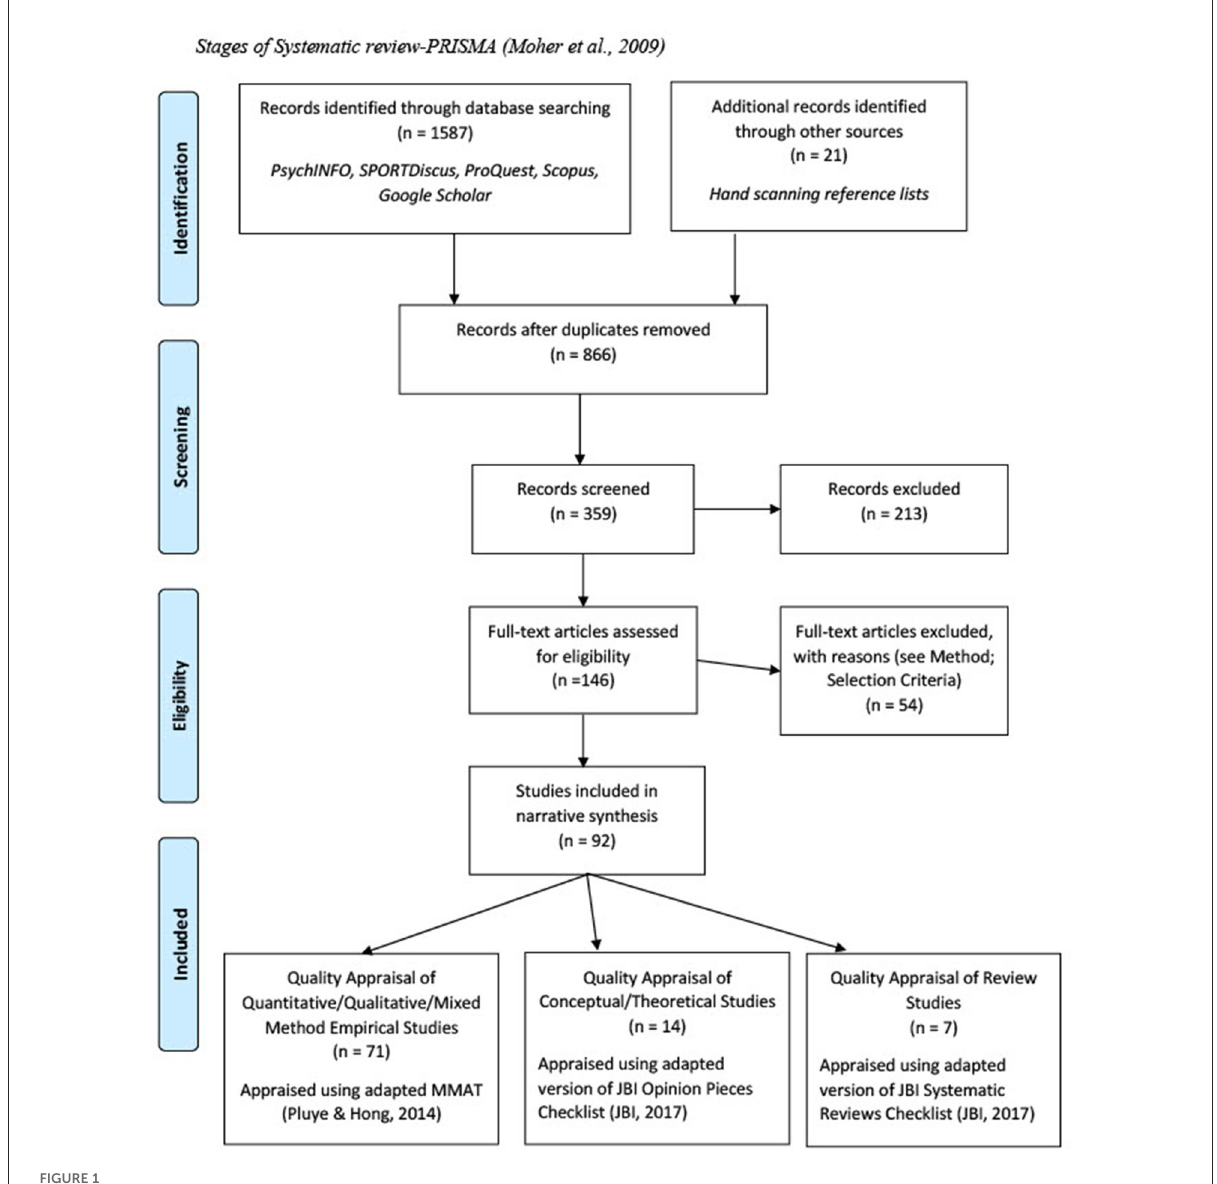
FIGURE1 Stages of systematic review-PRISMA (Moher et al.,